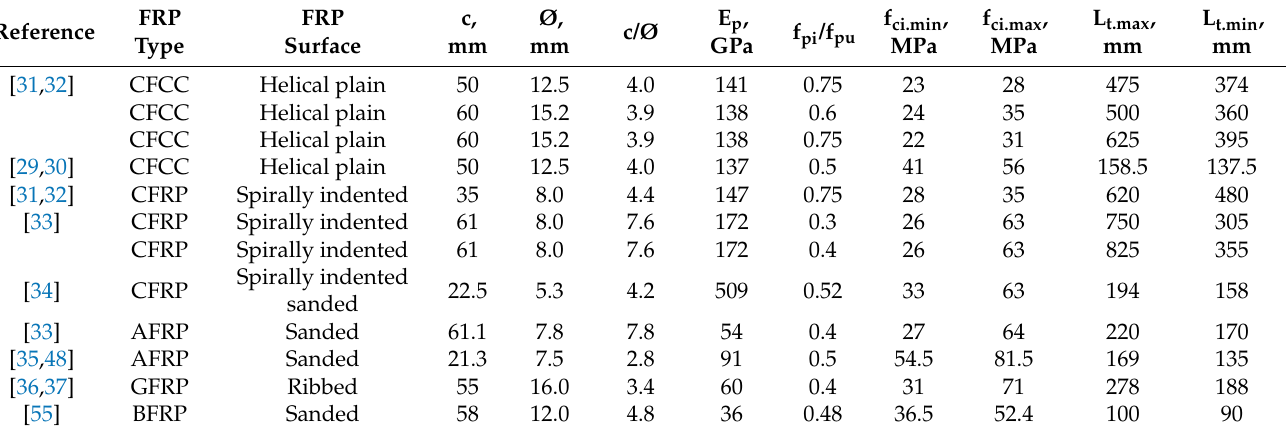
Table 2. Summary of transfer length results on the influence of concrete compressive strength at